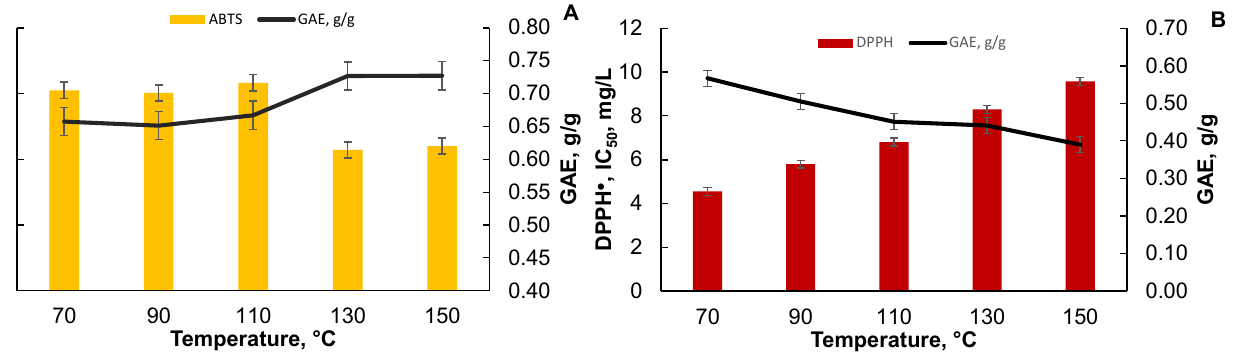
Figure 7. ( A ) Correlation of antioxidant activity (ABTS • + test) of the black alder bark ETC extracts and total polyphenol content. ( B ) Correlation of antioxidant activity (DPPH • test) of the black alder bark ETH extracts and total polyphenol content.